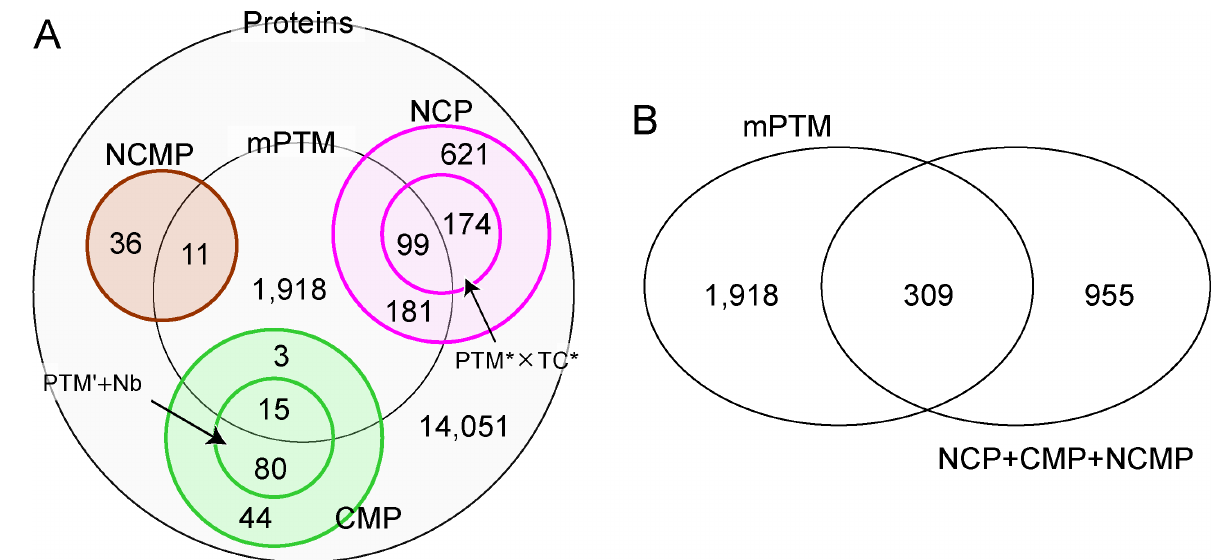
Fig 5. Venn diagrams showing the overlap of the proteins that undergo post-translational modifications multiple times (mPTM) [27], and the multiple-localized hub proteins. The mPTM proteins were obtained from Supplementary File 2 of [27]. We regarded mPTM proteins as proteins that undergo PTM more than once (exactly speaking, the classification group symbol in the File is at least 2), and did not decompose further classifications. Proteins with PTM that were not annotated in the File were disregarded. A. Detailed classification. The small circles in NCP and CMP are the proteins with PTM * × Transcription * (TC * ) and those with PTM ’ + Nucleotide- binding (Nb), respectively. B. Schematic